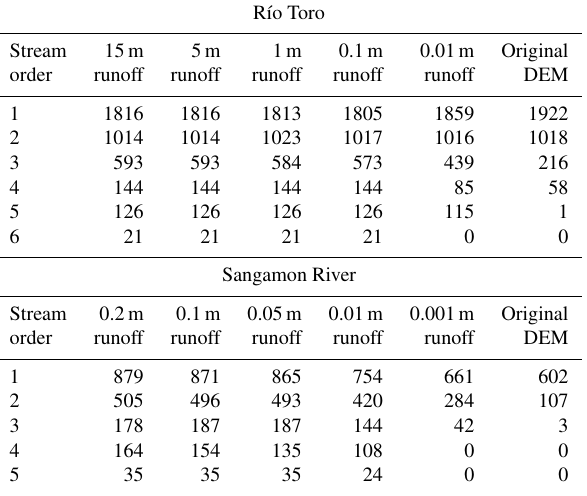
Table 4. Number of streams of each Strahler order at each study site after flow-routing surfaces were created using different amounts of runoff. Deeper initial runoff was able to fill more depressions, in- tegrating flow across them and building higher-order drainage net-